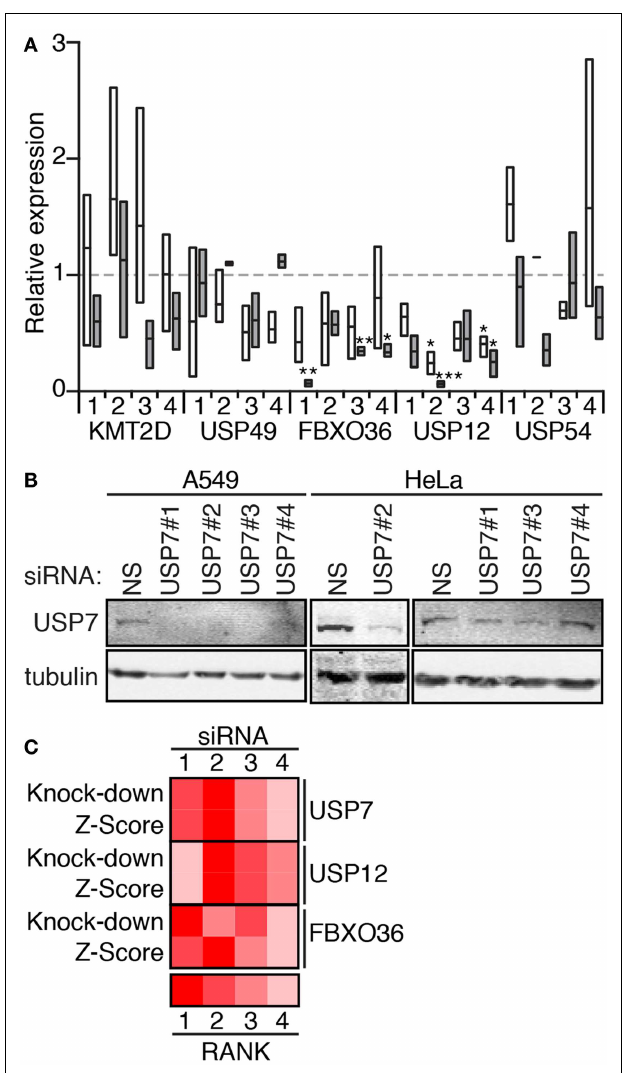
FIGURE 7 | (A) Expression of the indicated genes in HeLa cells (open boxes) and A549 cells (gray boxes) treated with the corresponding siRNA (numbered 1–4). Box plots represent the three independent measurements and expression levels are reported relative to cells treated with a control non-silencing siRNA. Statistical evaluations were performed with a one-way ANOVA analysis comparing each sample mean to the non-silencing mean individually. One, two, and three asterisks indicate p values below 0.05, 0.01, and 0.001, respectively. (B) Western blot evaluation of lysates from A549 and HeLa cells treated with a control non-silencing siRNA (NS), or four independent siRNA duplexes that target USP7. Samples were probed with anti-USP7 antibodies and counter-probed with a tubulin antibody as a loading control. (C) Rank score evaluation of phenotypic severity for individual siRNAs that target USP12, USP7, and FBXO36 ( z -score), and knock-down efficiency (knock-down for the corresponding siRNAs). z -Score data for USP12 are from the 30minTNF exposure data presented in Figure 6 , and z -score data from USP7 and FBXO36 are from the 120min TNF exposure data presented in Figure 6 .